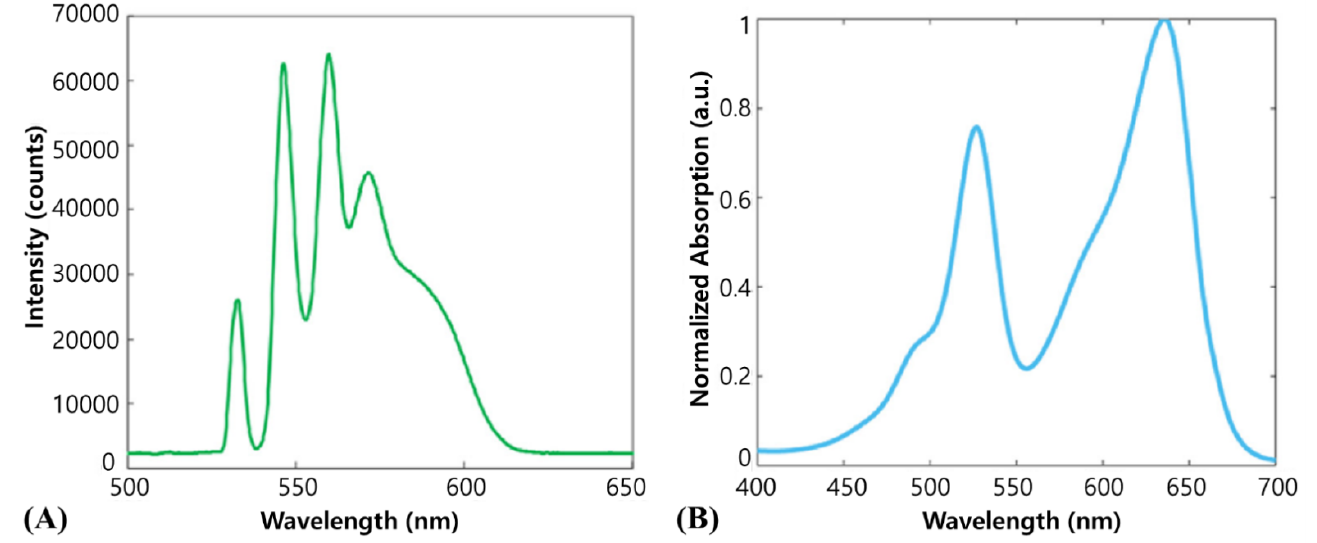
Figure 19. ( A ) Optical wavelengths emitted from the 532 nm fiber-coupled laser. ( B ) The absorption spectrum of the Wright–Giemsa stain. Reprinted from Strohm et al., Photoacoustics, 2016, 4, 1: 36–42 [38], with permission of Elsevier.